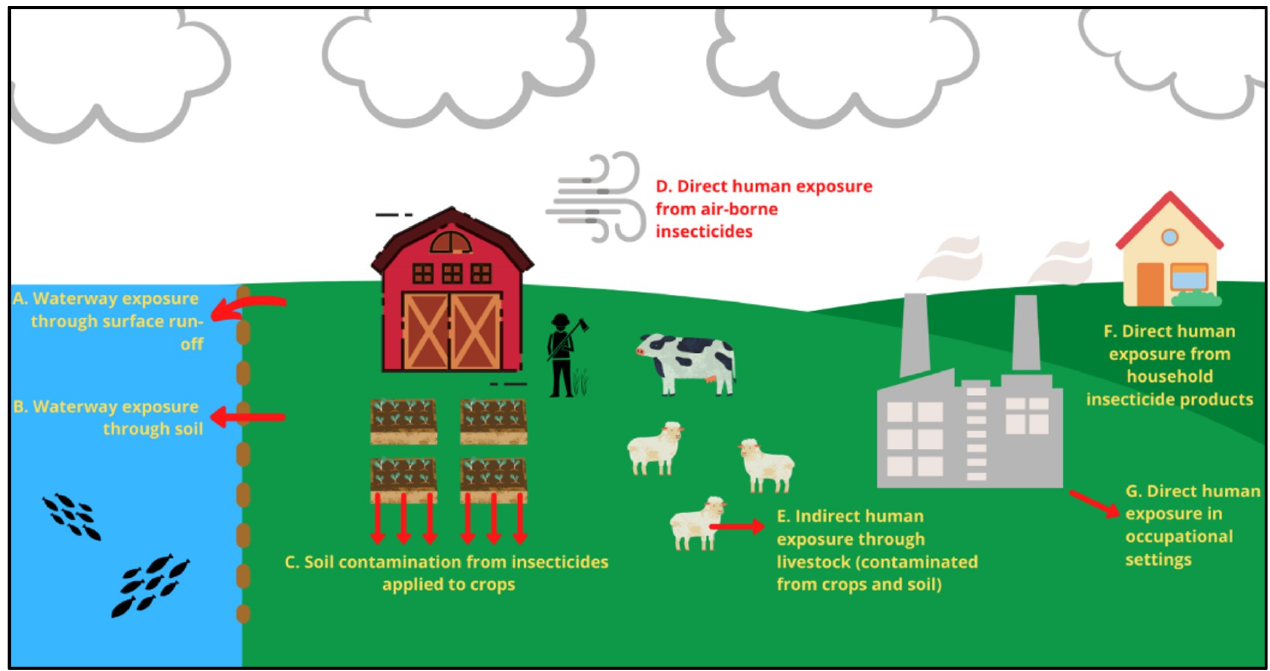
Figure 2. The primary direct and indirect routes of organophosphate (OP) exposure on target and non ‐ target organisms in agricultural, household and aquatic environments.